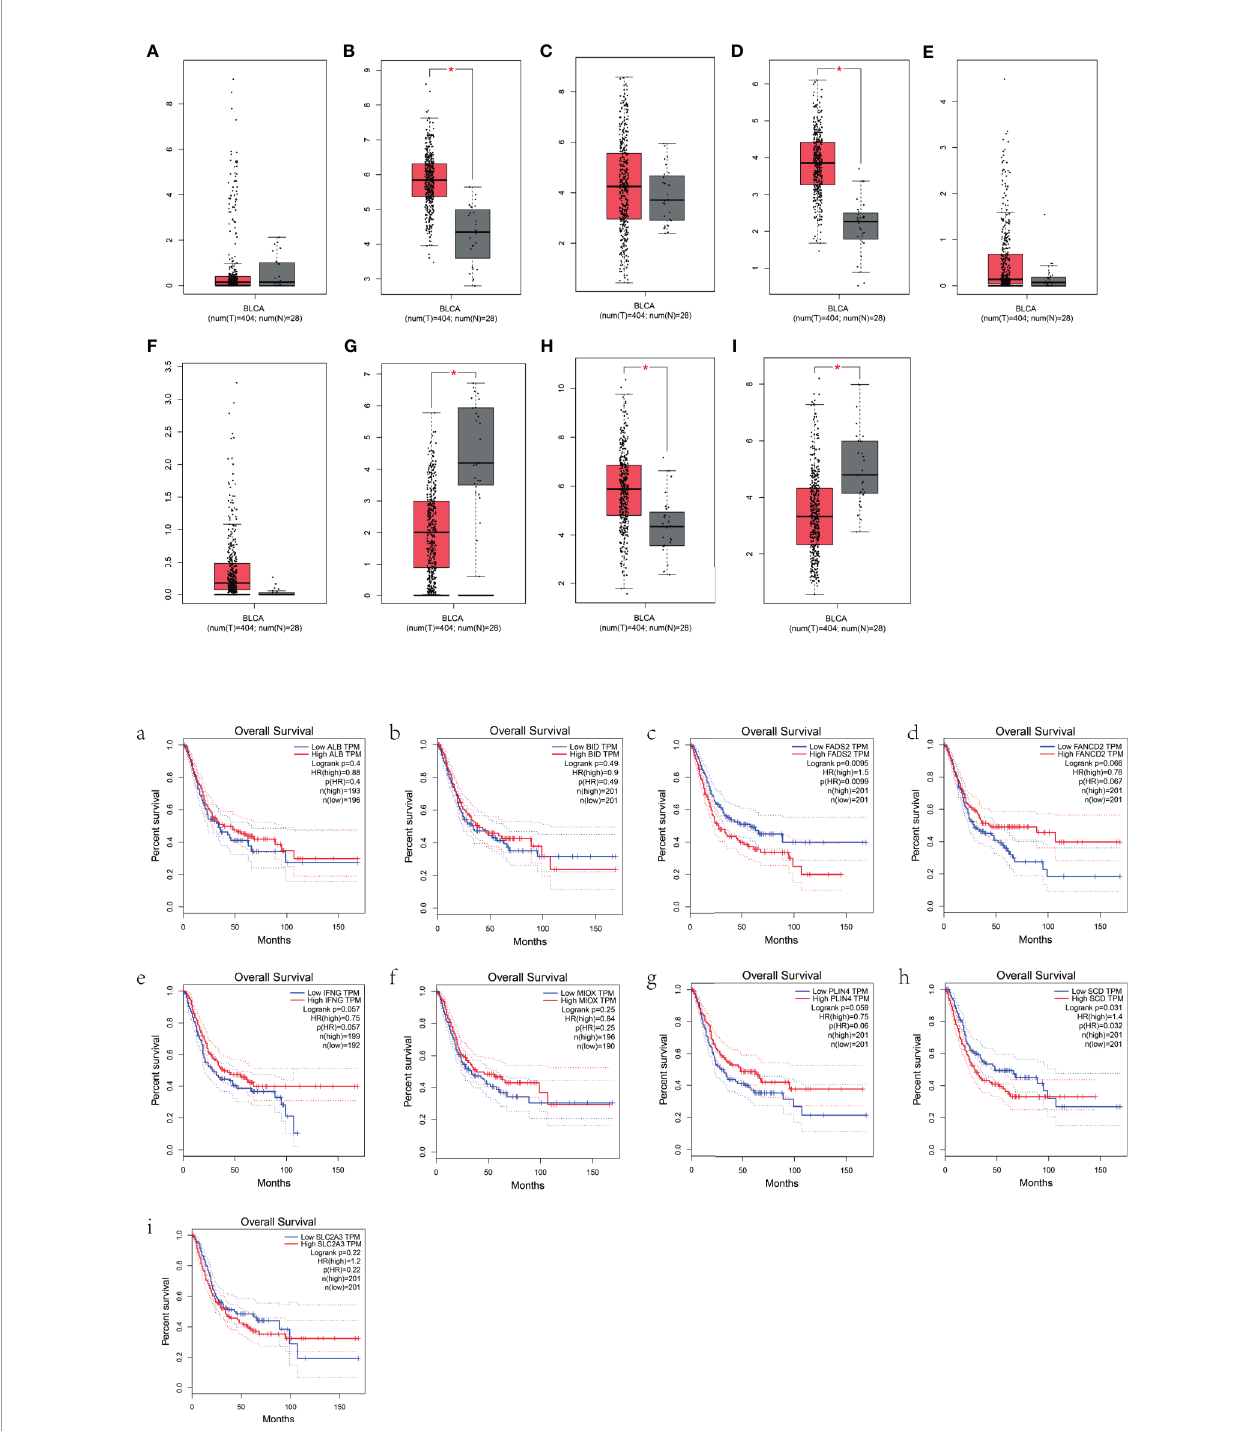
FIGURE 5 | Prognostic analysis of the BLCA patients based on the expression of FRGs. (A – I) Box plots show the differences in the expression of nine different ferroptosis-related genes in the tumor and normal tissues from the GEPIA dataset. (a – i) The overall survival of BLCA patients based on the expression of the nine FRGs is